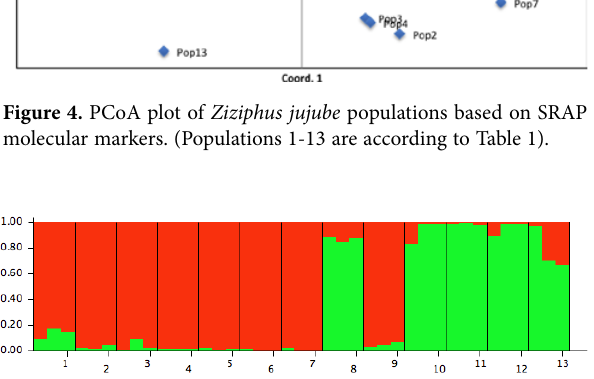
Figure 5. Top: STRUCTURE plot of Ziziphus jujuba populations based on SRAP data. Bottom: STRUCTURE plot based on k = 2 (Populations 1-13 are according to Table